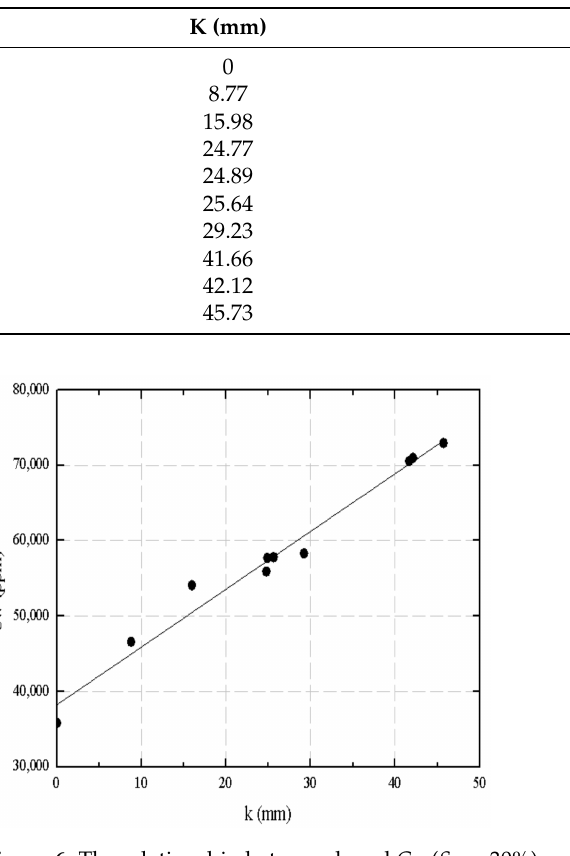
Figure 6. The relationship between k and C w ( S w = 30%). Table 3. The value of k corresponding to the target formation water salinity C w ( S w = 30%). C w (ppm) K